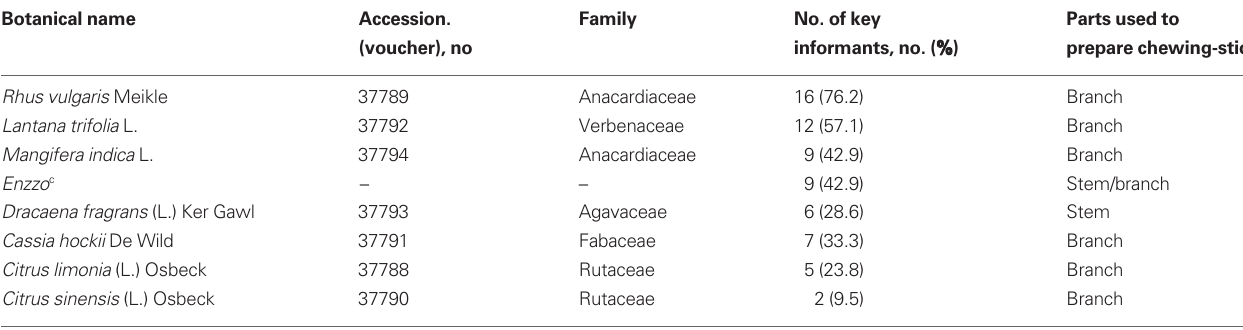
Table 1 | Plant sources of chewing-sticks in Sango and Buwanda villages as reported by key informants ( n =